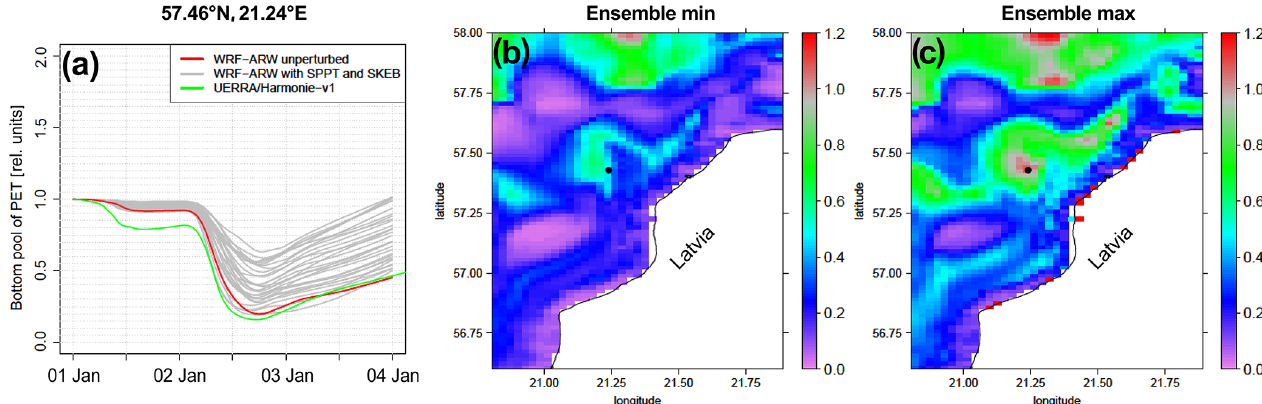
Figure 9. (a) Change in the seafloor concentration of PET particles with a 10µm diameter in one selected grid cell in 30 perturbed runs and 1 unperturbed run with WRF forcing and 1 run with UERRA/HARMONIE-v1 forcing. (b) Ensemble minimum and (c) ensemble maximum on 4 January 2019 at 00:00UTC (at the end of the simulation). All concentrations are relative to the homogenous initial concentration. The black dots show the locations for the time series plots.